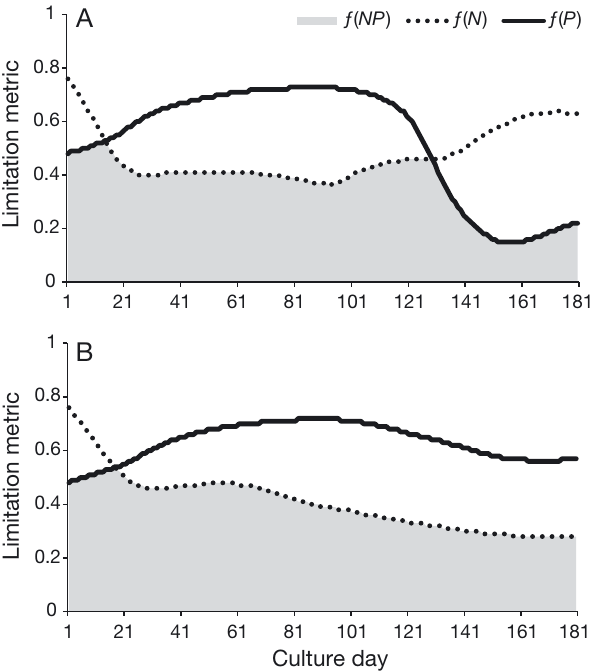
Fig. 7. Nutrient limitation factors on the growth of cultured kelp Saccharina japonica . Results of normalized functions for the concentration of dissolved inorganic nitrogen ( N) , phophorus ( P) or both ( NP , grey shaded area) over time are shown; a value close to the gray shaded area indicates growth limitation. (A) 2011−2012, (B)